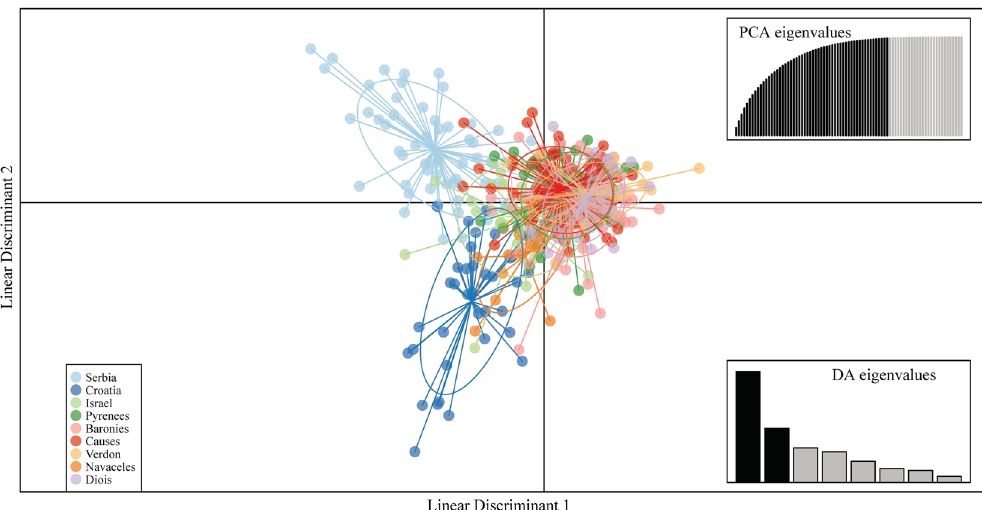
Figure 2. Discriminant analysis of principal components in which LDA was performed on the first 56 PCs (out of 83 PCs since there were a total of 83 observed alleles) which cumulatively conserve 98.7% of the total variance. The first and second lienar discriminant are presented in the plot.